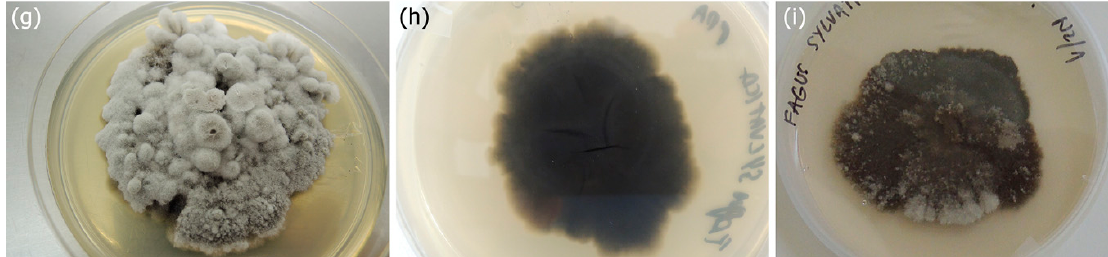
Figure 3. Pathogenicity test on Fagus sylvatica : ( a ) Control on the 21st day; ( b ) necrotic leaf spots on the 21st day; ( c ) a lesion developed under a propagule on the 2nd day; ( d ) fresh mycopappus-like propagules developed on a necrotic spot on the 14th day; ( e ) appressorium formation (arrows) on the 11th day; ( f ) disintegration of the inoculated propagule on the 21st day; ( g , h ) upper and reverse side of culture re-isolated from newly formed mycopappus-like propagule on PDA, respectively; ( i ) re-isolation from newly formed mycopappus-like propagule on MEA.